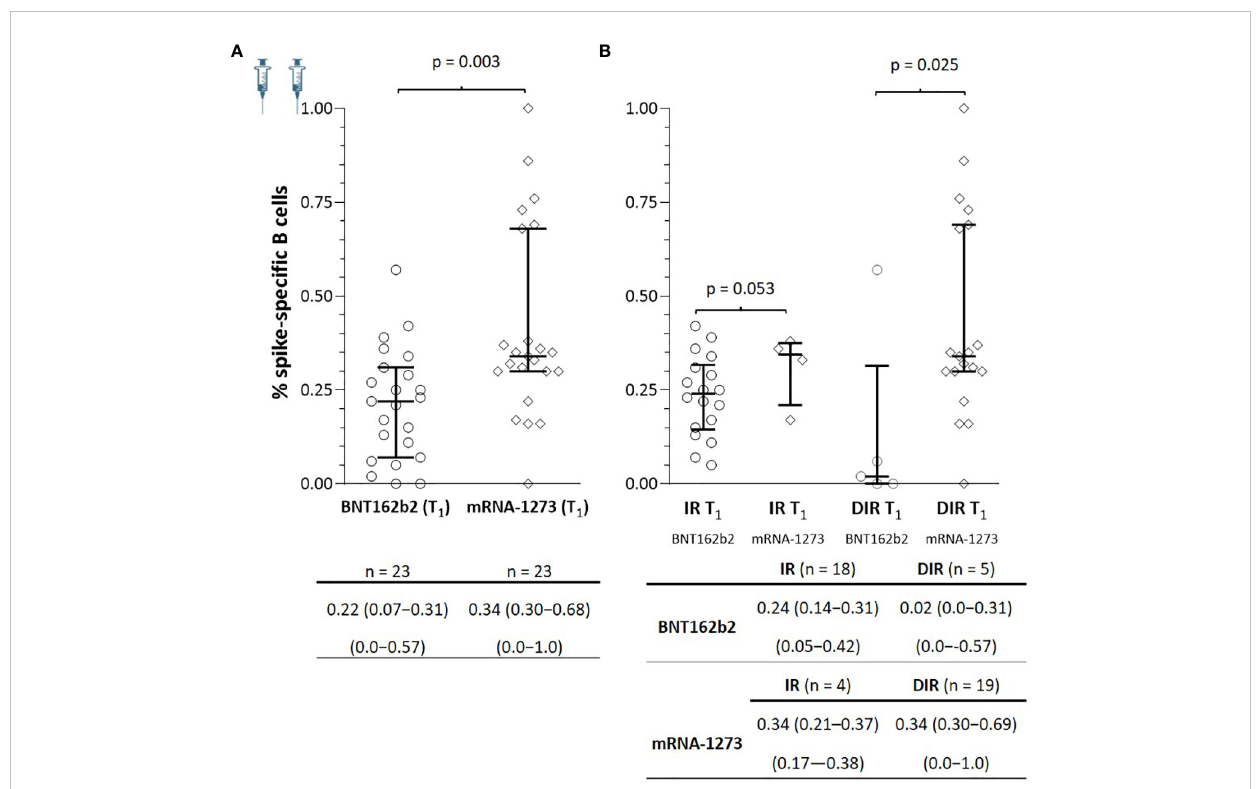
FIGURE 5 (A) Speci fi c SARS-CoV-2 memory B cells one month after the two mRNA vaccine doses (T 1 ) according to the vaccine received and (B) according to the group of participants (IR, immune responders. DIR, discordant immune responders) and the vaccine received.